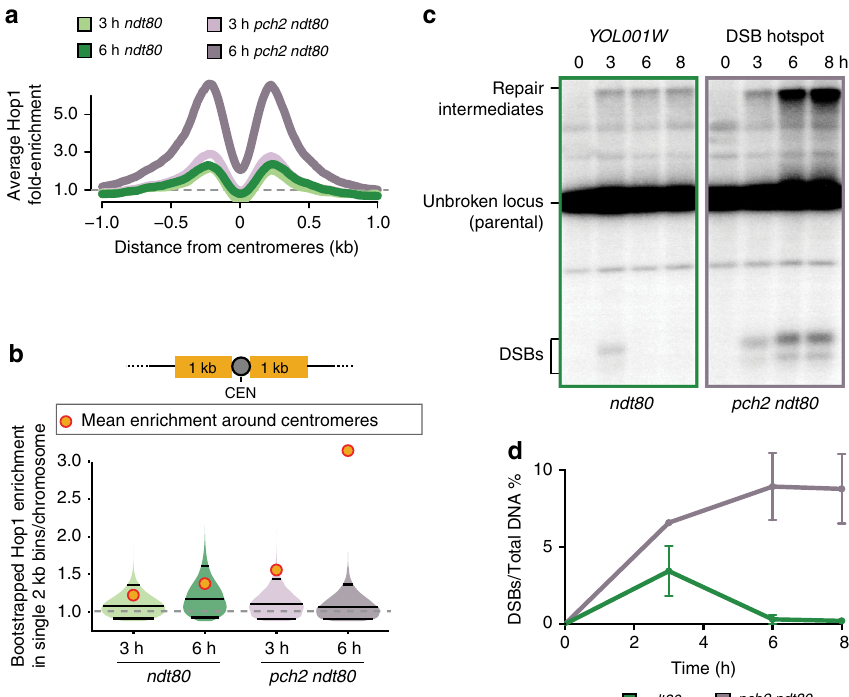
Fig. 5 Pch2 controls regional distribution of Hop1 and DSBs around centromeres. a Mean Hop1 enrichment around the centromeres normalized to genome average as a function of the distance from centromeres in ndt80 Δ , and pch2 Δ ndt80 Δ . The gray dashed line is genome average. b Bootstrap-derived distributions within single 2-kb bins per chromosome are illustrated as violin plots for Hop1 ChIP-seq data from ndt80 Δ , and pch2 Δ ndt80 Δ mutants. The horizontal lines in the violin plots represent the median and the two-ended 95% CIs. The mean Hop1 ChIP-seq enrichment around centromeres (2 kb) for the respective samples is shown as orange/red dots. c Southern analysis of DSBs at the YOL001W DSB hotspot near CEN15 in ndt80 Δ , and pch2 Δ ndt80 Δ . Percentage of DSBs over total DNA at the YOL001W locus at the indicated time points is shown in d . The data are mean of two independent biological replicates and error bars represent the